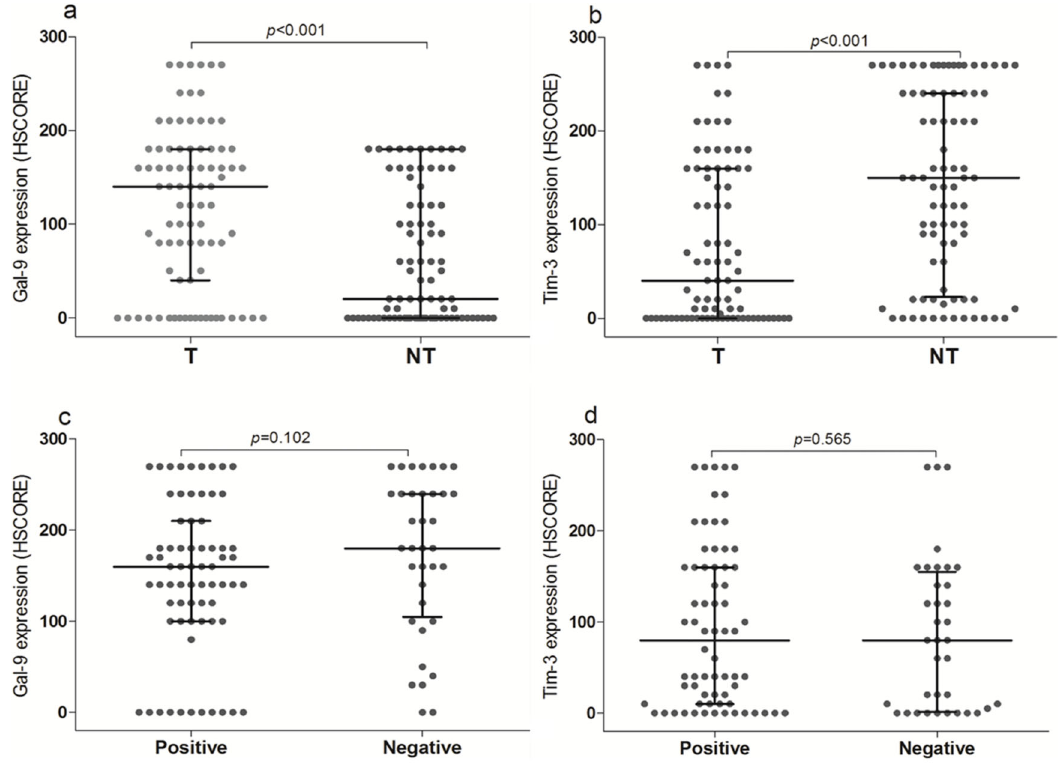
Figure 3. Gal-9 expression was significantly higher in gastric tumor tissues (T) compare to those in paired adjacent non-tumor tissues(3a), and Tim-3 HSCORE in cancer lesion was significantly lower than those in normal mucosa(3b). However, no differences of Gal-9(3c) or Tim-3 expressions (3d) were found between patients with H . pylori infection (Positive) and without H.pylori infection (Negative).